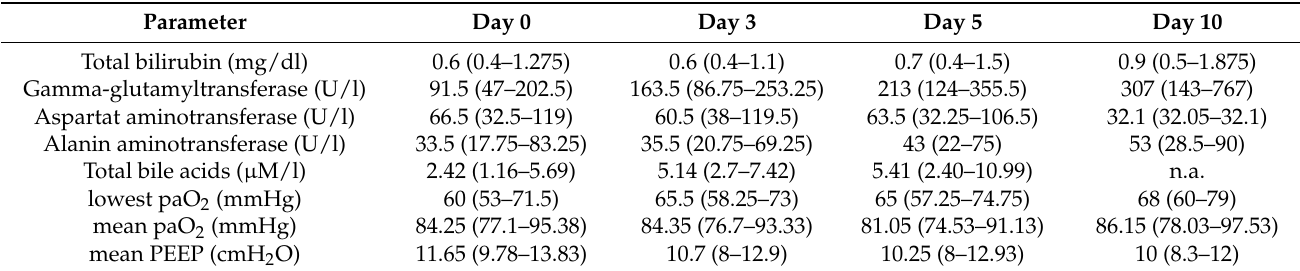
Table 2. Median and interquartile range for measured biomarkers as well as paO 2 levels and mean PEEP of all patients after winsorization.